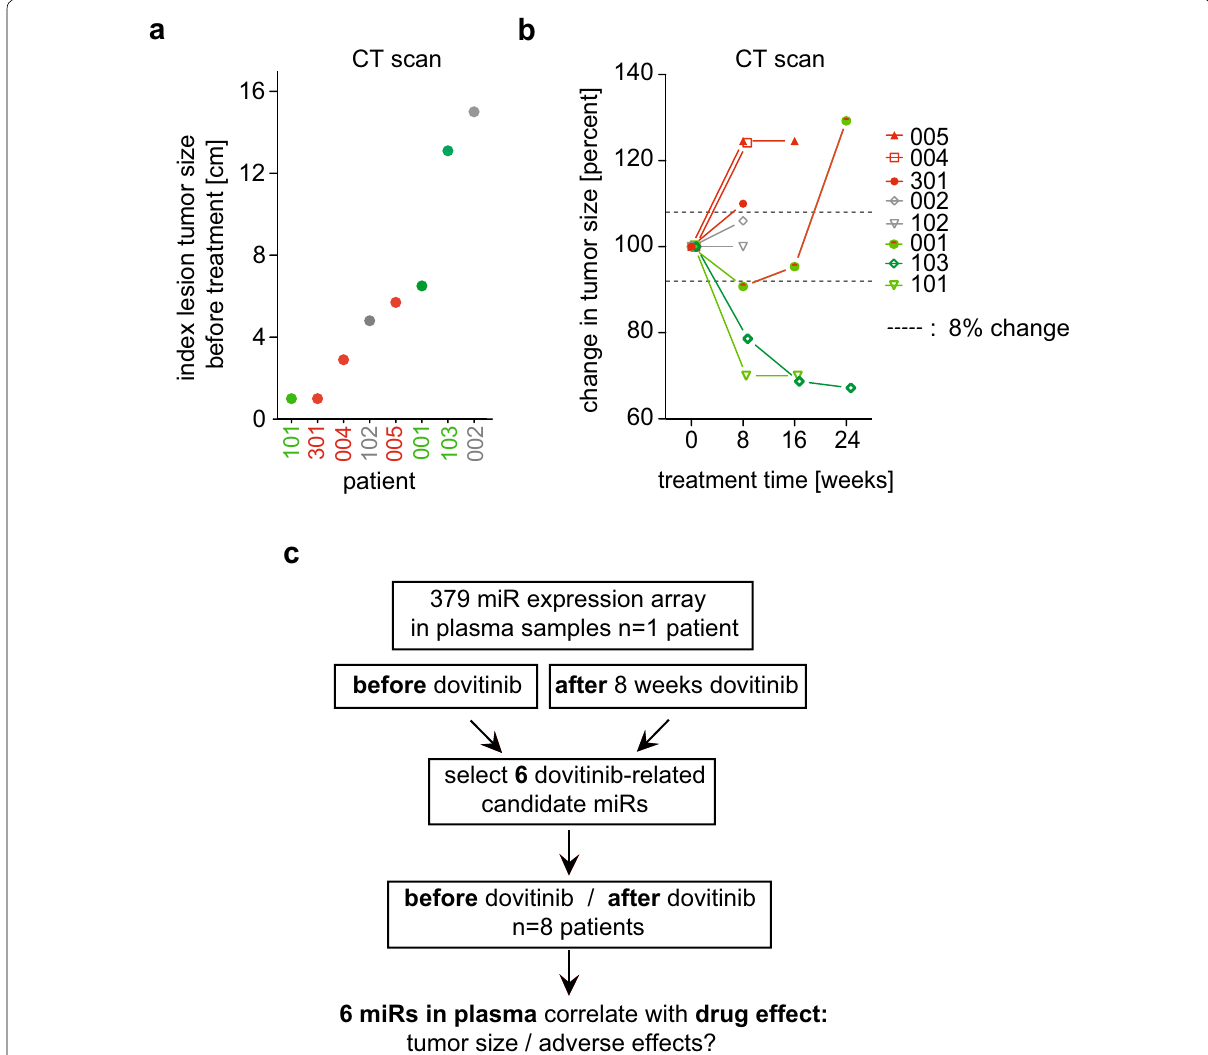
Fig. 1 Breast cancer lesion sizes, treatment responses and design of the miR analysis. a Patient numbers are color coded to indicate changes in tumor sizes after 8 weeks of treatment (red increase, green decrease, grey no change). The sizes of the index lesions were measured by = = = CT before treatment with dovitinib (baseline). b Change in tumor size of the index lesion during the course of dovitinib treatment. c Flow chart of plasma miR analysis design. From a genome wide miR expression array with samples collected before and after dovitinib treatment in a single patient, 6 signature miRs were selected and tested for their indication of a dovitinib response in 8 patients. Further criteria for selection of the miRs are provided in the “Results”